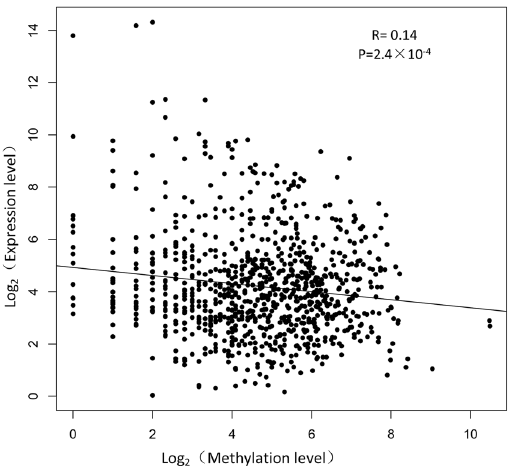
Figure 5. Scatter plot of the lincRNAs expression and methylation levels in three groups. The Pearson’s correlation was calculated between the log2 ratios of lincRNAs expression and the log2 ratios of lincRNAs methylation. The line represents regression line. The statistical significance was calculated by R language (version: